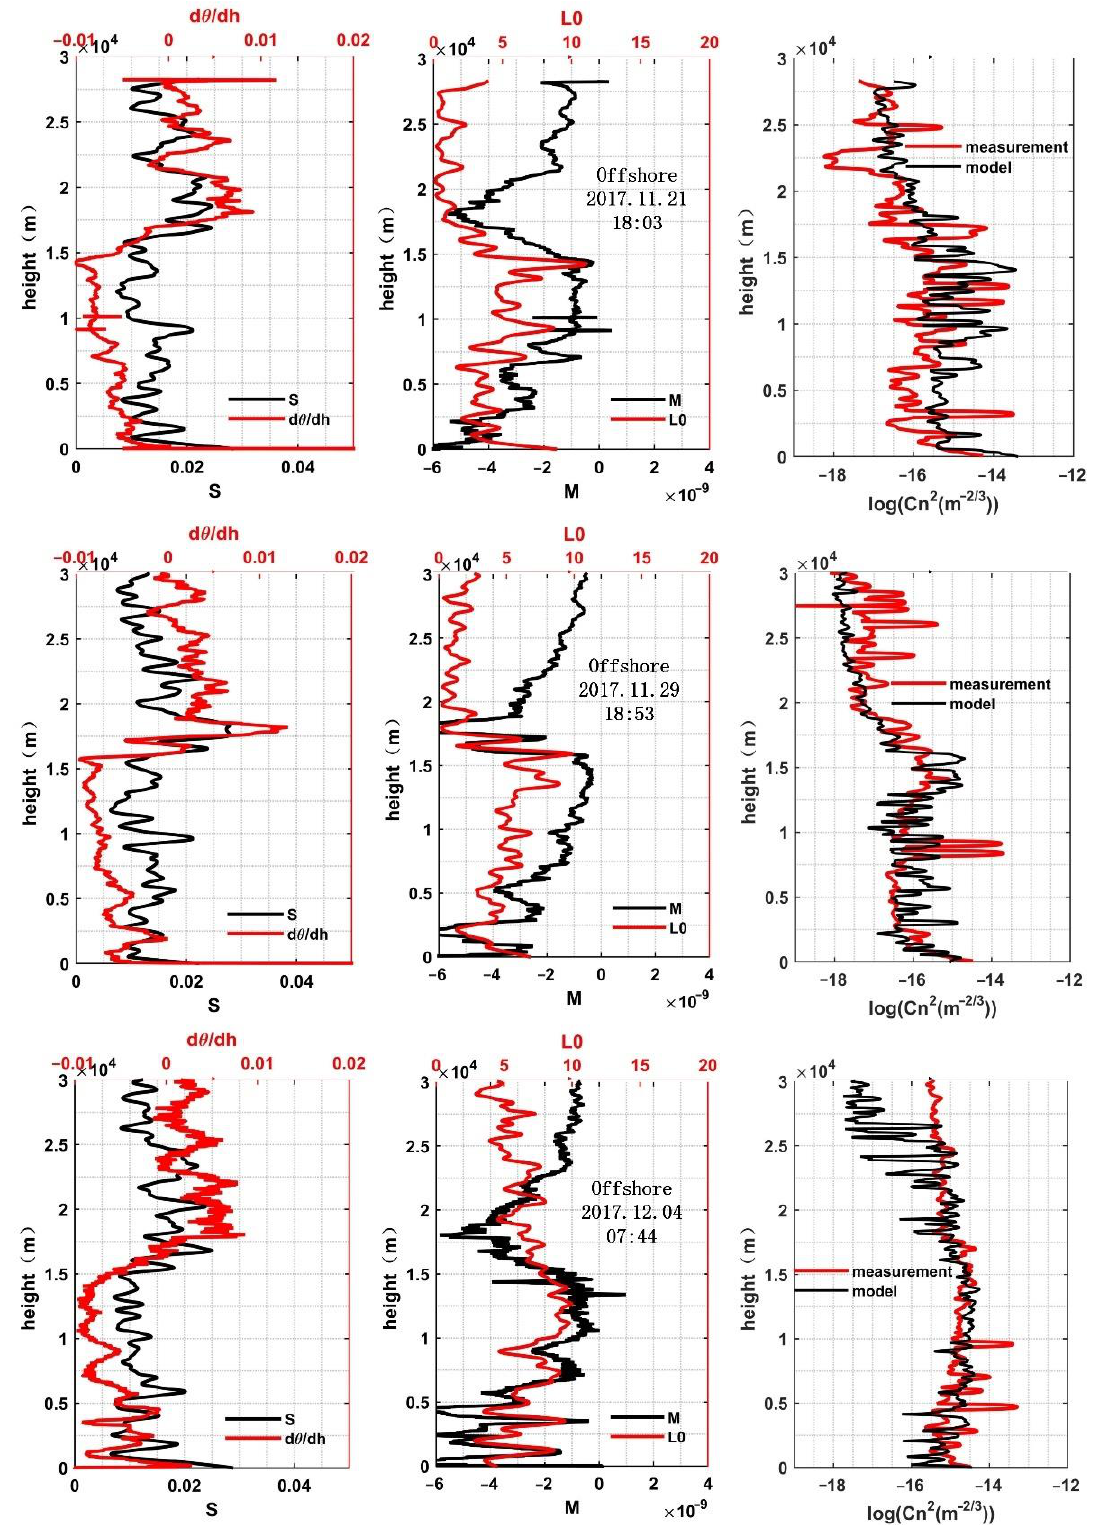
Figure 6. The profiles of temperature gradient, wind shear ( left ), outer scale, and potential refractive index gradient ( middle ), as well as C 2 n profiles of estimated and measured ( right ) in offshore area.